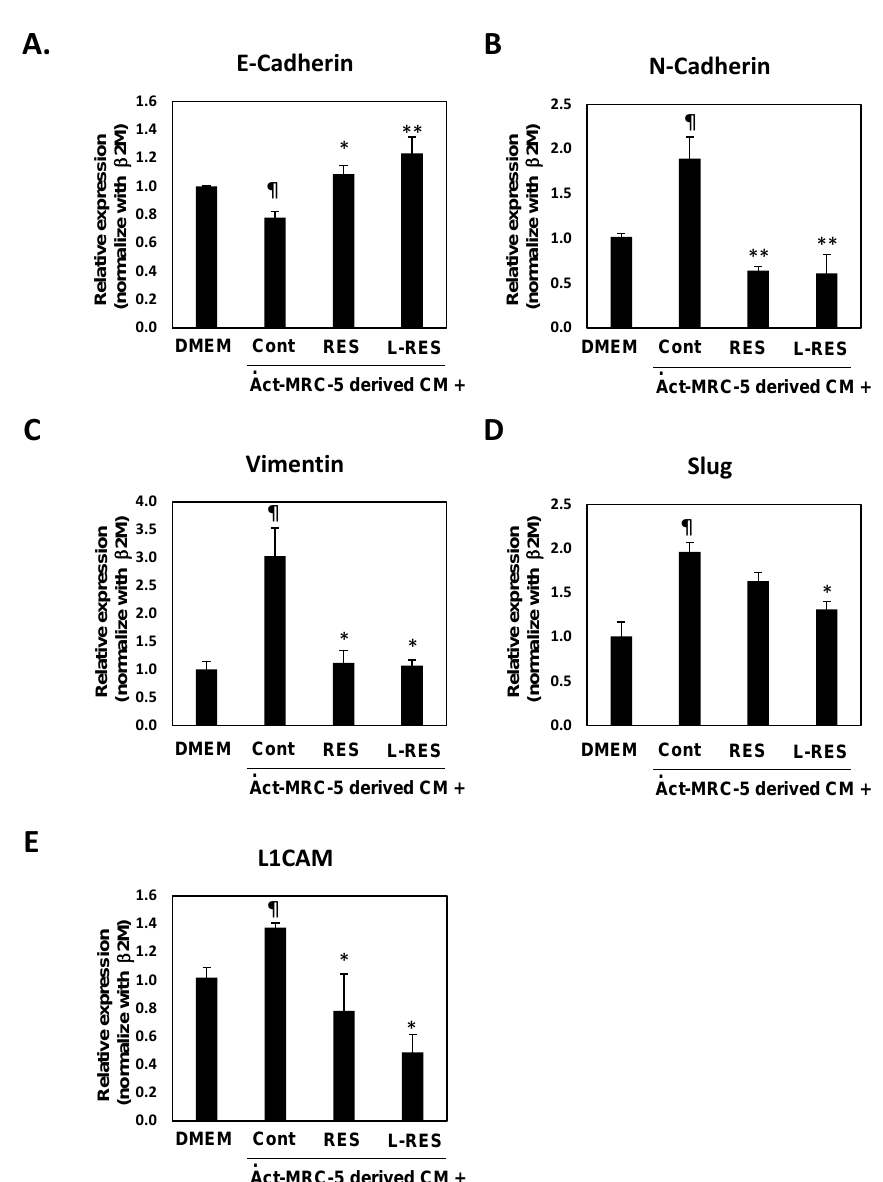
Figure 8. Activated-fibroblast-induce EMT related genes in CRC cells and abrogated by L-RES treatment. The expressions of EMT and L1CAM related to cell migration and invasion in CRC cells, namely ( A ) E-cadherin, ( B ) N-Cadherin, ( C ) Vimentin, and ( D ) Slug, were determined in HT-29 cells treated with conditioned medium derived RES or L-RES pretreated Act-MRC-5 using quantitative real-time PCR. Relative mRNA expression was calculated (untreated control cells = 1). The data are means ± SD from the representative experiments. * p < 0.05, ** p < 0.01, *** p < 0.001 vs Act-MRC-5 control. ¶ p < 0.05 vs DMEM control.